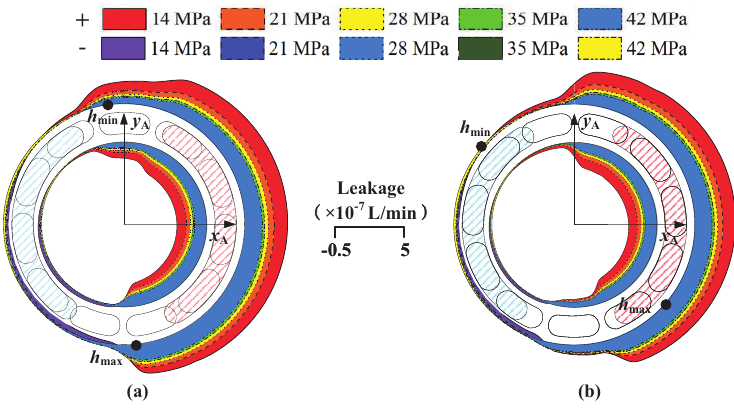
Figure 20. Leakage at different pressures. ( a ) θ = 0. ( b ) θ = π .